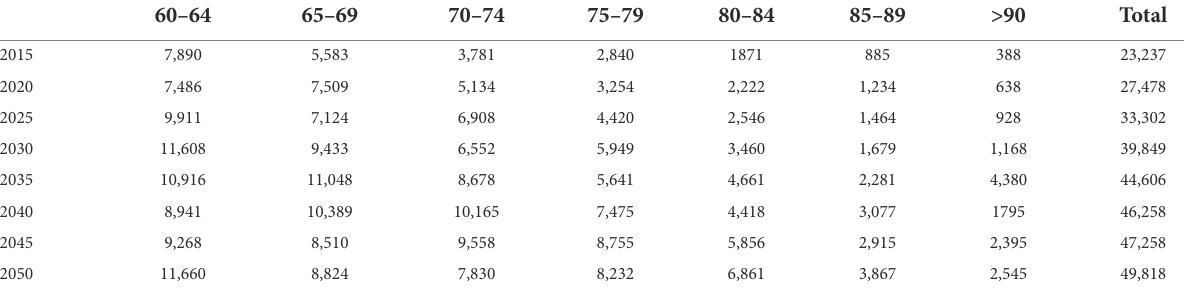
TABLE 1 Forecast results of the Chinese older population from 2015 to